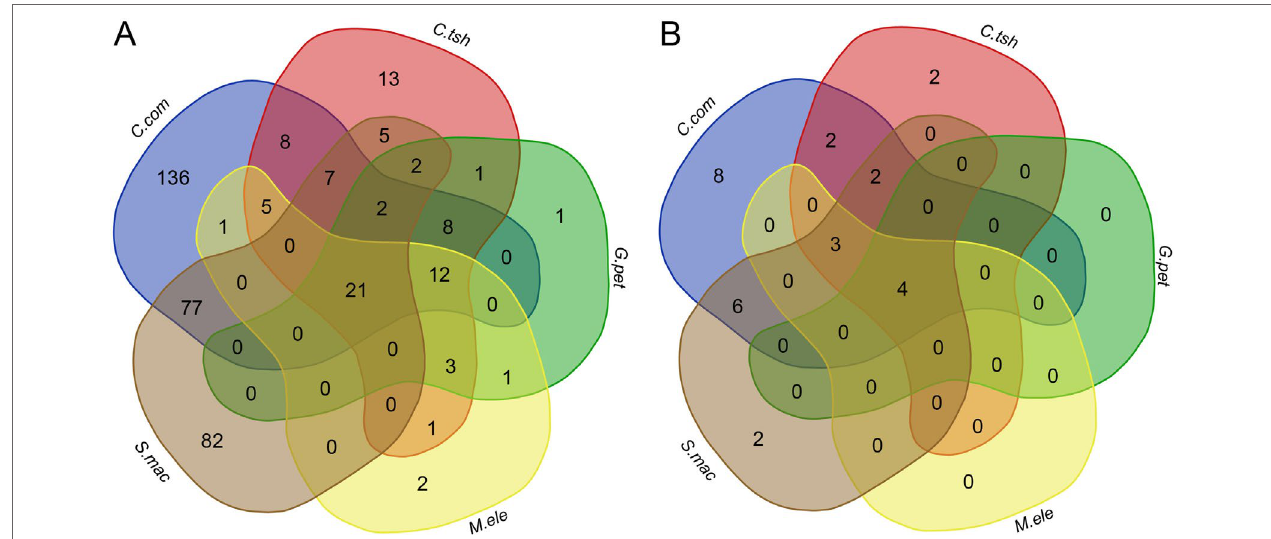
FIGURE 6 | Comparison analysis of GO categories and KEGG pathways for DEGs between the SM and EO tissues among five electric fishes. (A) Venn diagram of the significantly enriched GO categories for DEGs among five electric fishes (FDR < 0.05). The numbers represent the number of significantly enriched GO categories. (B) Venn diagram of the significantly enriched KEGG pathways for DEGs among five electric fishes (FDR < 0.05). The numbers represent the number of significantly enriched KEGG